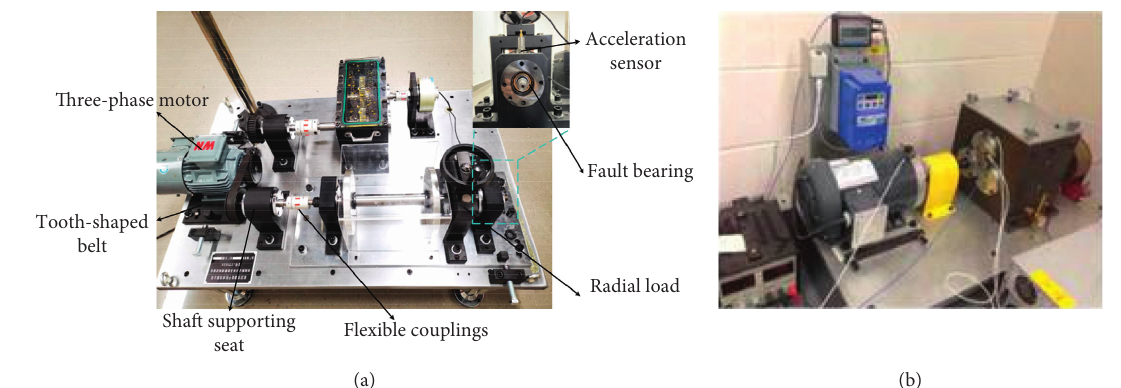
Figure 7: (a) Lab-built experimental platform and (b) gearbox experimental platform.